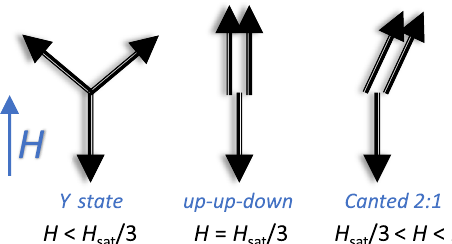
FIG. 1. Planar spin configurations of a single-layer triangular lattice antiferromagnet at 0 K and finite magnetic fields